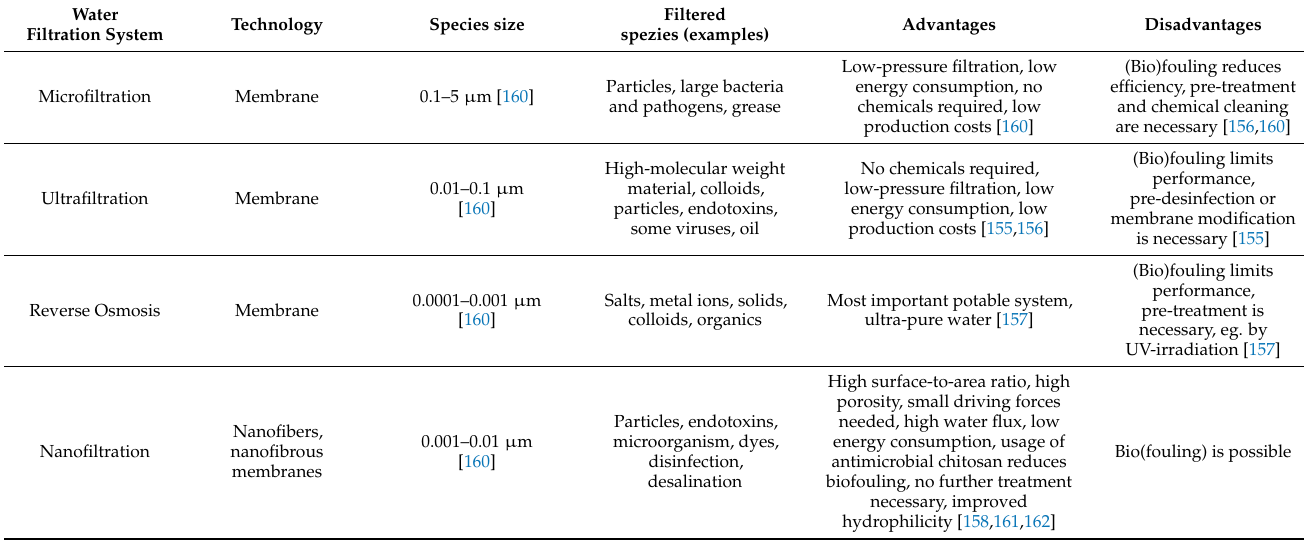
Table 1. Comparison of different water filtration